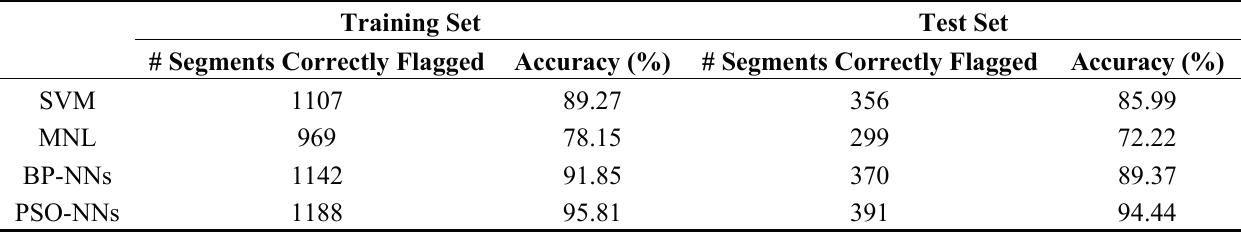
Table 3. Comparison among several classifiers for detecting travel